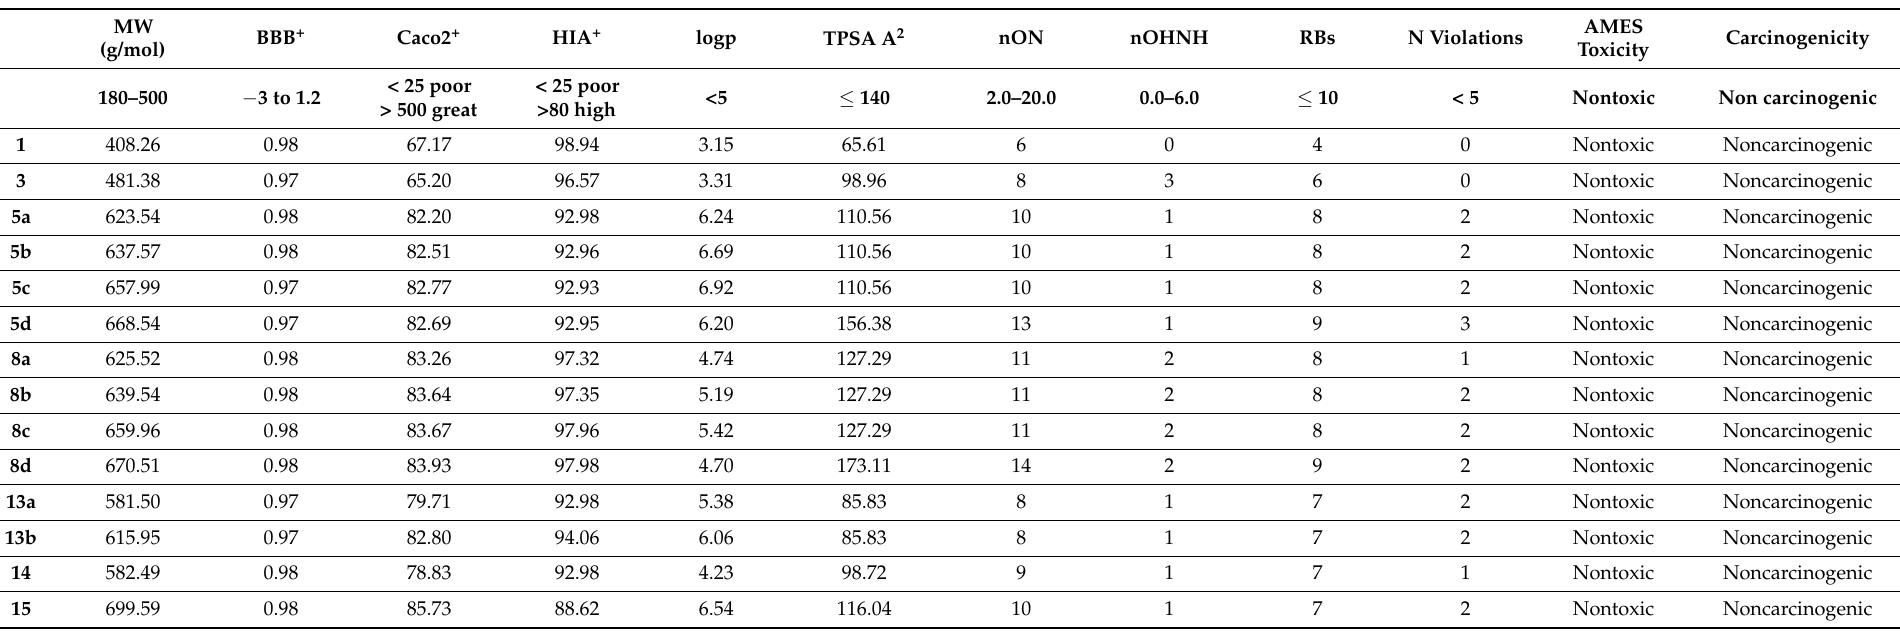
Table 2. List of ADME and physicochemical properties of the title compounds 1 – 15